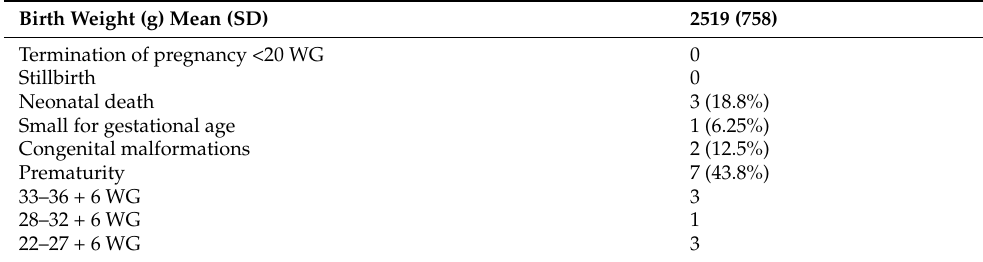
Table 2. Fetal/neonatal complications— n = 16 (one twin pregnancy).